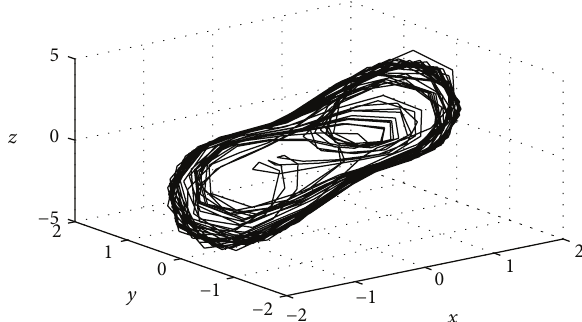
Figure 2: 3D Duffing chaotic system phase